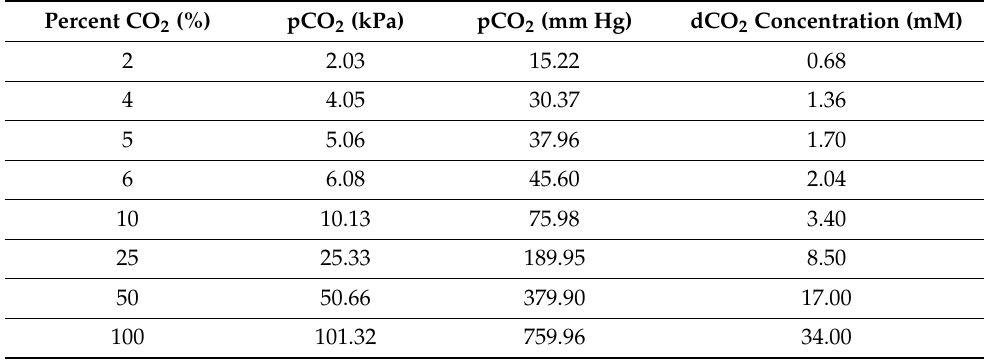
Table 1. List of CO 2 concentrations used in this